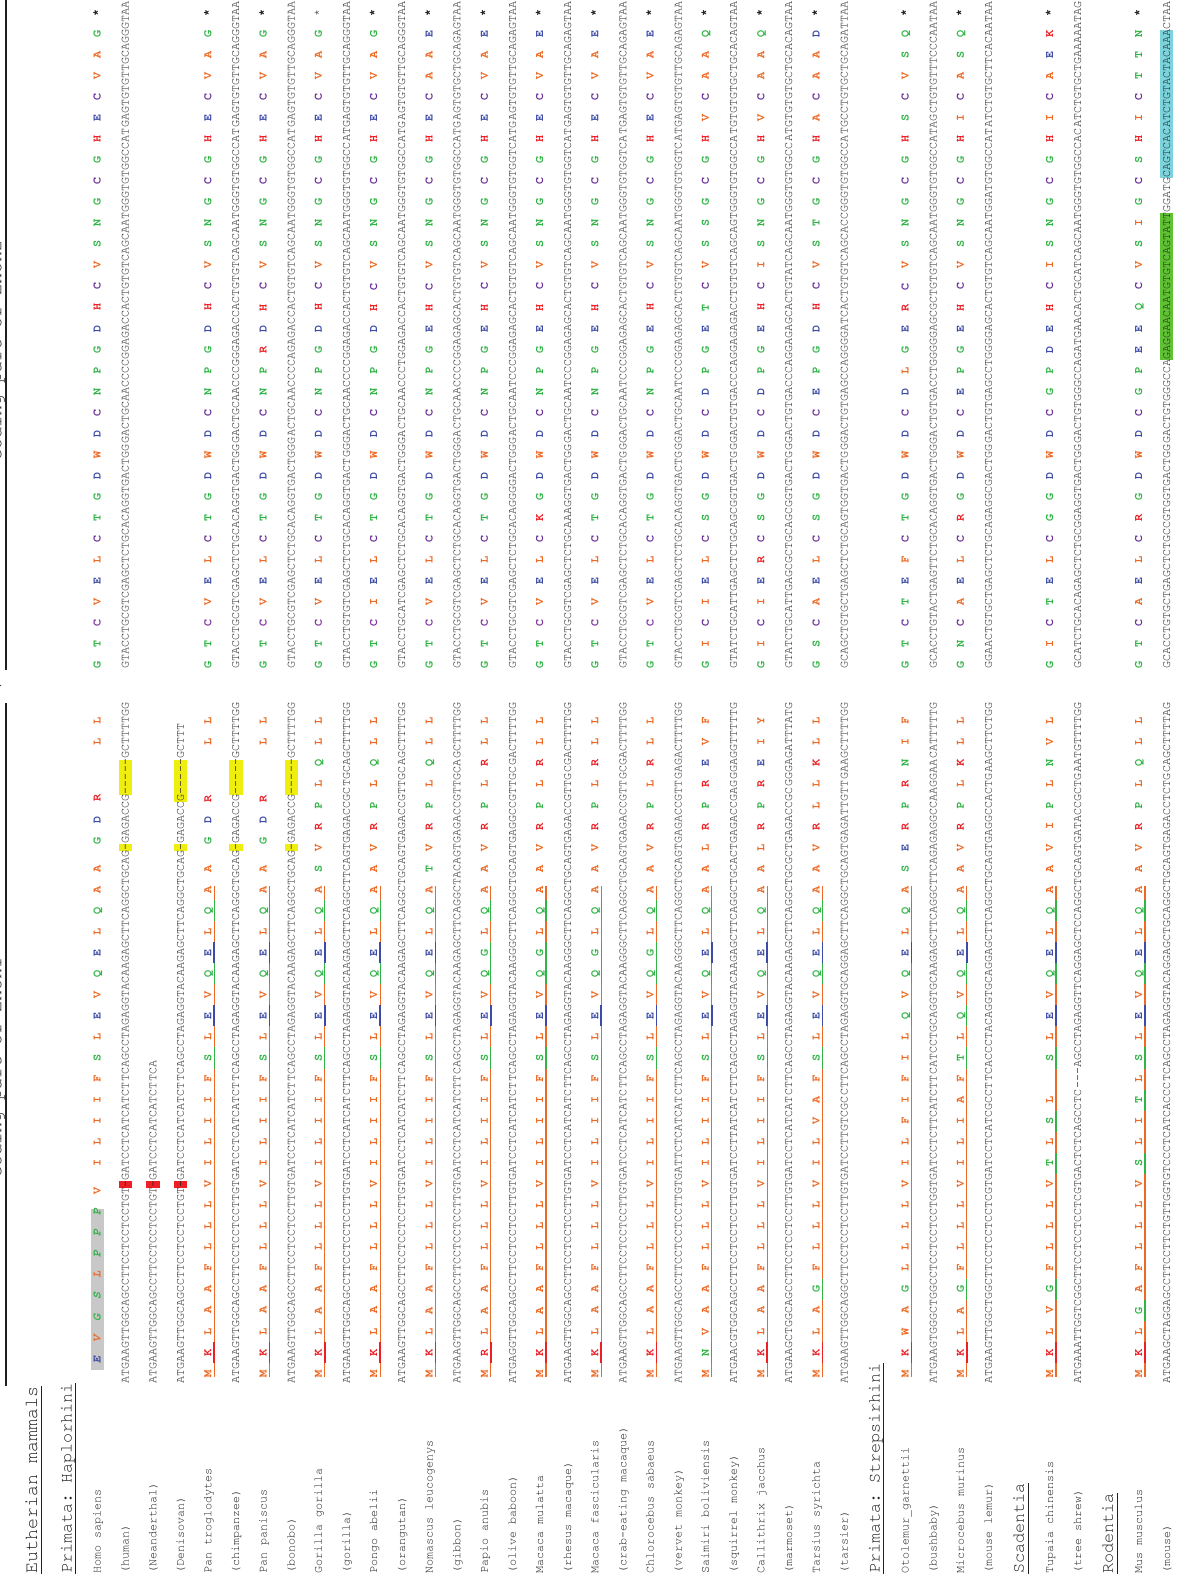
als mamm Eutherian